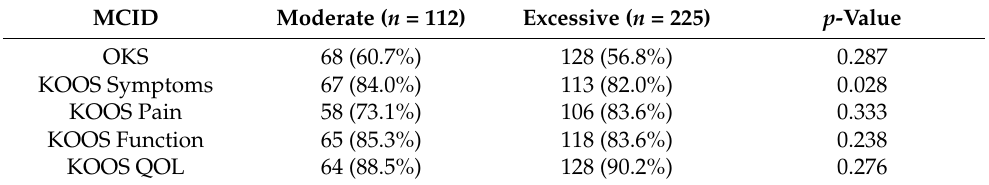
Table 3. Number and percentage of patients achieving minimal clinical differences (MCID) of the Ox- ford Knee Score (OKS) and the Knee Injury and Osteoarthritis Outcome Score (KOOS) subcategories in the restricted versus excessive